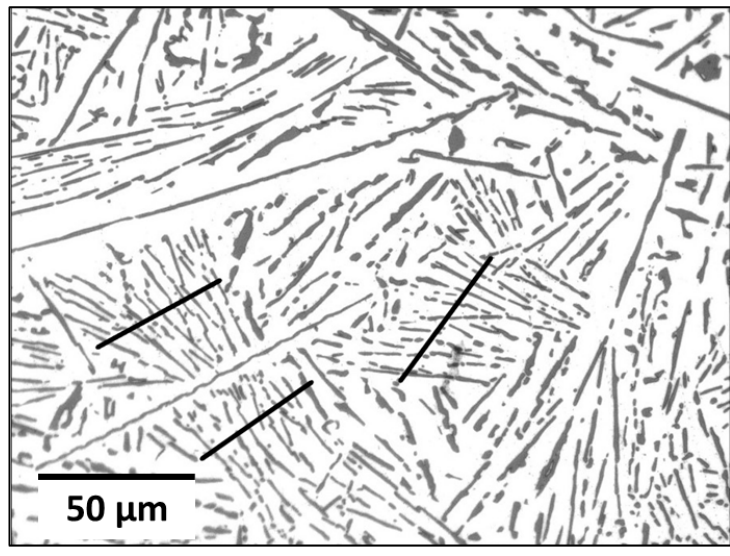
Figure 1. Line intercept method (M = 500×).